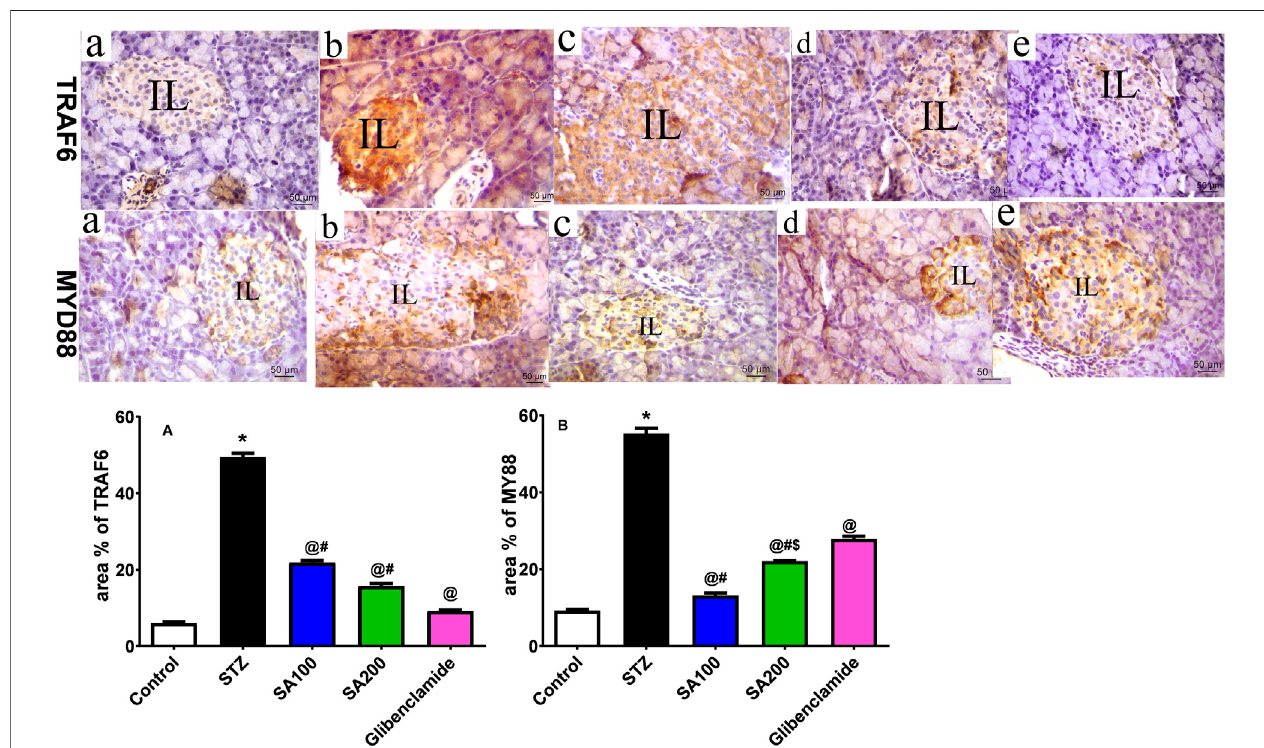
FIGURE 8 | (Upper panel) Immunostained photomicrographs of pancreatic sections presenting tumor necrosis factor receptor (TNFR)-associated factor 6 (TRAF6) and myeloid differentiation factor 88 (MyD88). Normal rats (A) , STZ diabetic rats (B) , S. aqueum (SA) extract (100 mg/kg) (C) , S. aqueum (SA) extract (200 mg/kg) (D) , and the reference drug, glibenclamide (E) . (lower panel) TRAF6 area percentage (%) (A) . MyD88 area percentage (%) (B) . Results are presented as mean ± SEM.*Signi fi cantdifferencerelatedtothenormalcontrolgroup, @ relatedtoSTZdiabeticrats, # relatedtoreferencedruggroup,glibenclamide,and $ related to SA100 at p < 0.05 by One-Way ANOVA and Tukey ’ s post hoc test, n (cid:2) 6.